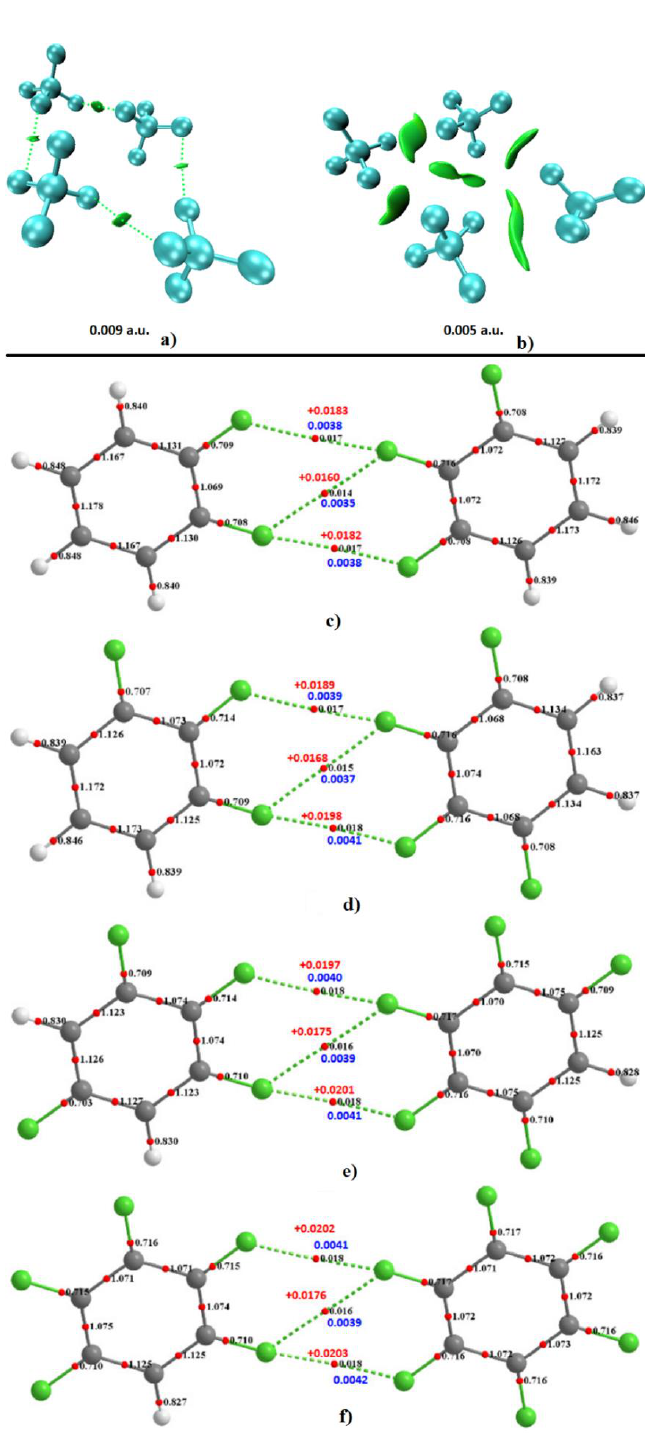
Figure 10. ( a ) 0.0090 a.u. (left) and ( b ) 0.0050 a.u. (right) isosurface plots of IGM analysis obtained from the unit cell of the CF 4 crystal (CSD Ref. TFMETH02). Included are the MP2/cc-pVTZ level QTAIM molecular graphs of some heteromolecular fluorine-substituted dimers [49] displaying Type-I and -III topologies of bonding (Scheme 1): ( c ) H 4 C 6 F 2 ···F 3 C 6 H 3 , ( d ) H 3 C 6 F 3 ···F 4 C 6 H 2 , ( e ) H 2 C 6 F 4 ···F 5 C 6 H, and ( f ) HC 6 F 5 ···F 6 C 6 ; formed even when the fluorine in the C 6 F 6 monomer is entirely negative. The charge density ( ρ b /a.u., blue), the Laplacian of the charge density ( ∇ 2 ρ b /a.u., red) at F···F bcps and the delocalization indices for each atom–atom pair (black) are shown. bcps: tiny red spheres; bond paths: solid and dotted lines in atom color; solid and dotted lines represent the open- and closed-shell interactions, respectively. For simplicity, rcps (ring critical points) are not